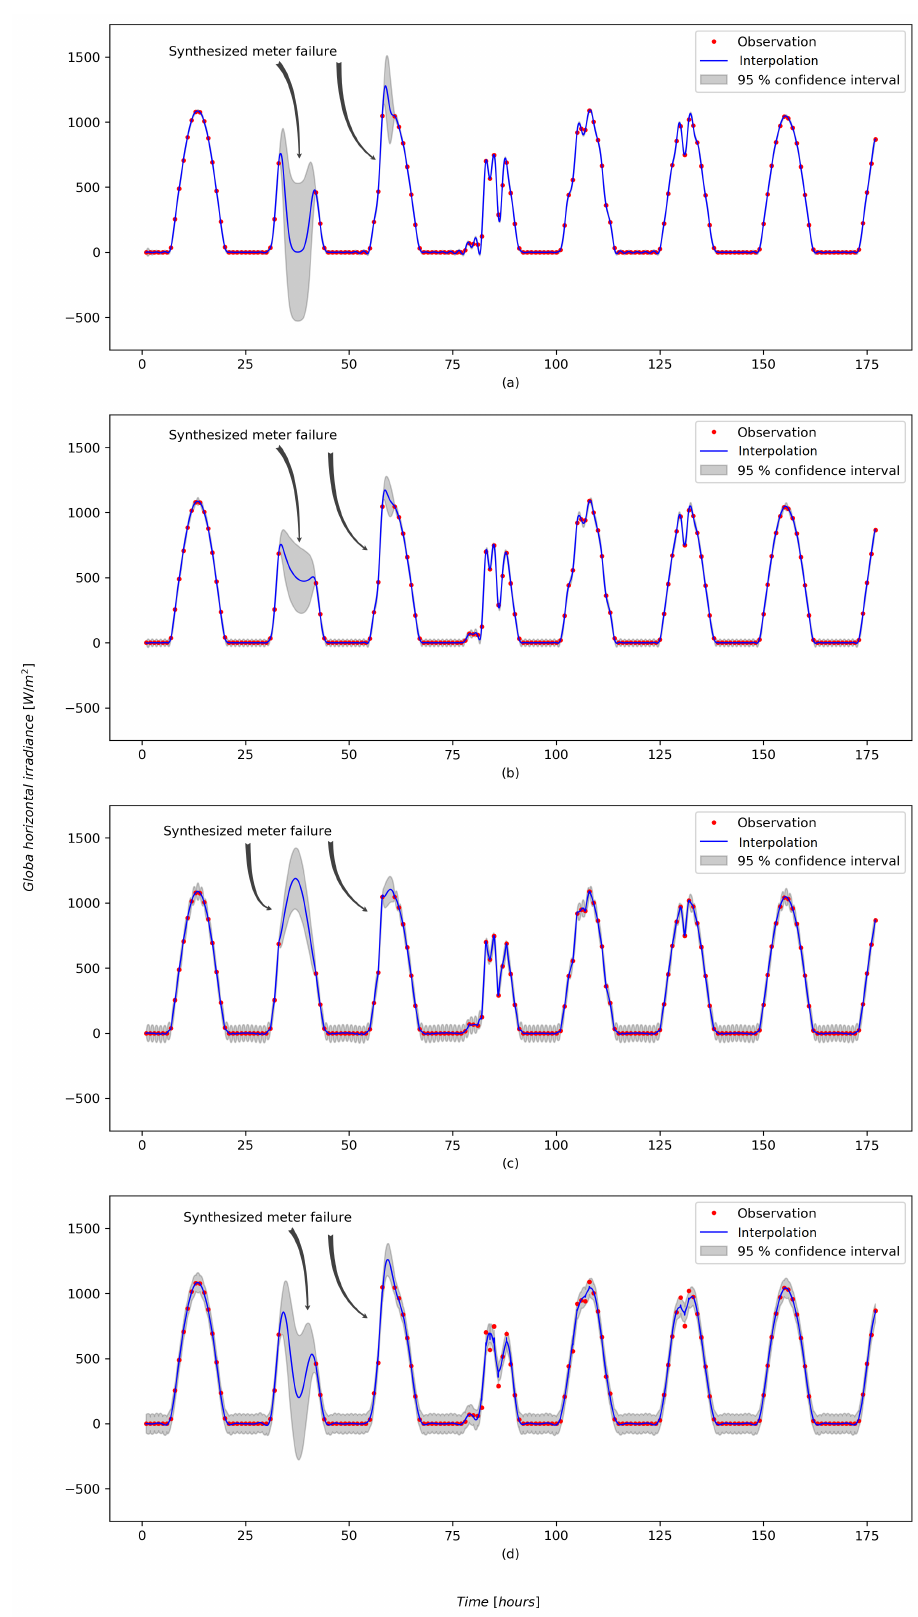
Figure 9. Interpolation of GHI-data using different kernels, with meter failure present in the data. ( a ) Per, ( b ) quadratic function (RQ), ( c ) Per × RQ and ( d ) RBF × (RQ +